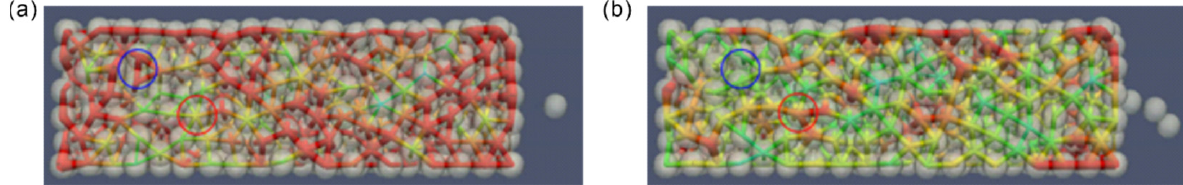
Table 1. Parameters for the sand particles in the simulation. Parameter